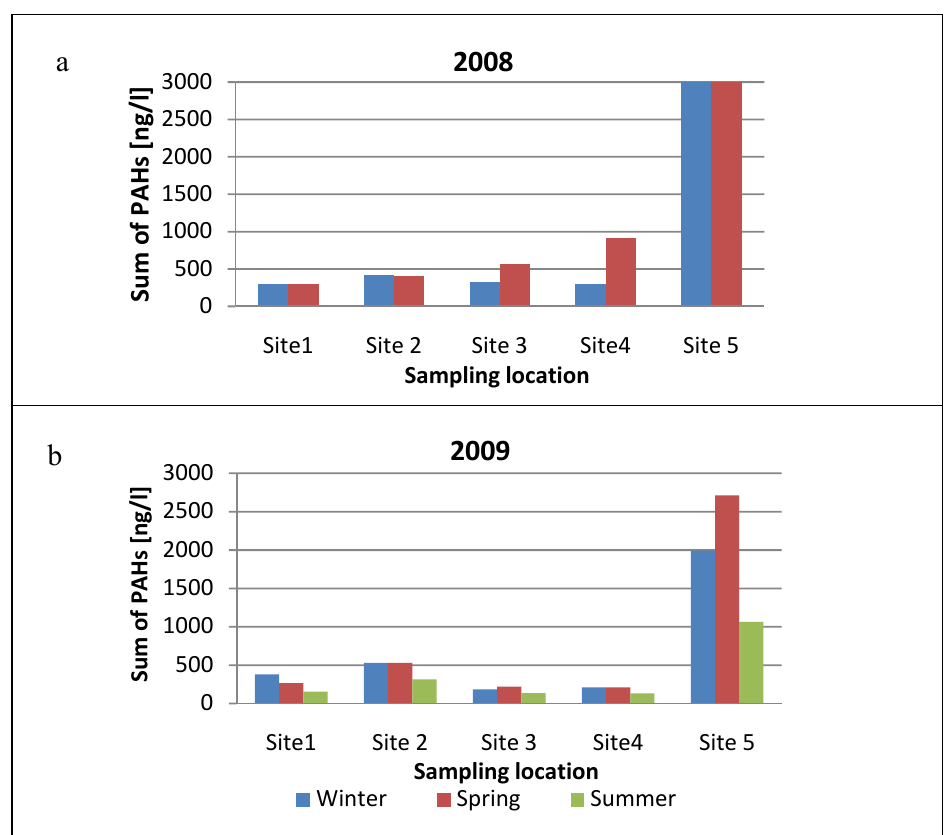
Figure 4. Seasonal changes in total PAH concentrations in runoff water samples collected in